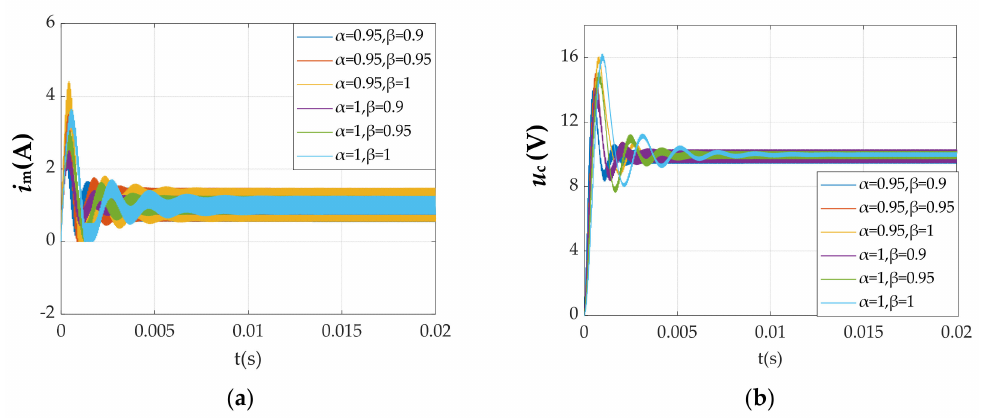
Figure 9. ( a ) The response waveforms of the inductor current under di ff erent α and β . ( b ) The response waveforms of the output voltage under di ff erent α and β